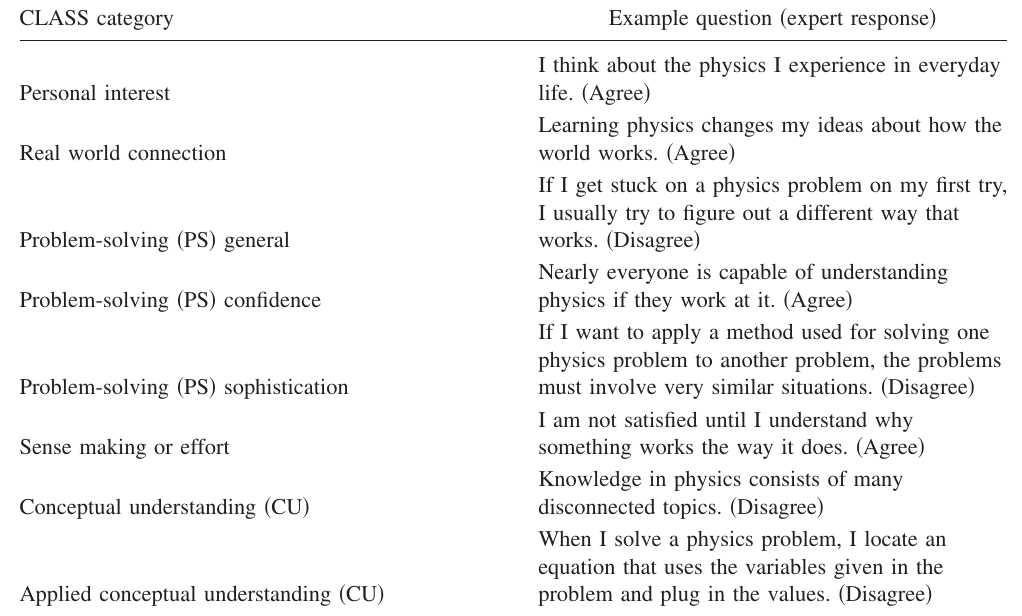
TABLE II. Categories of the CLASS instrument with example questions.